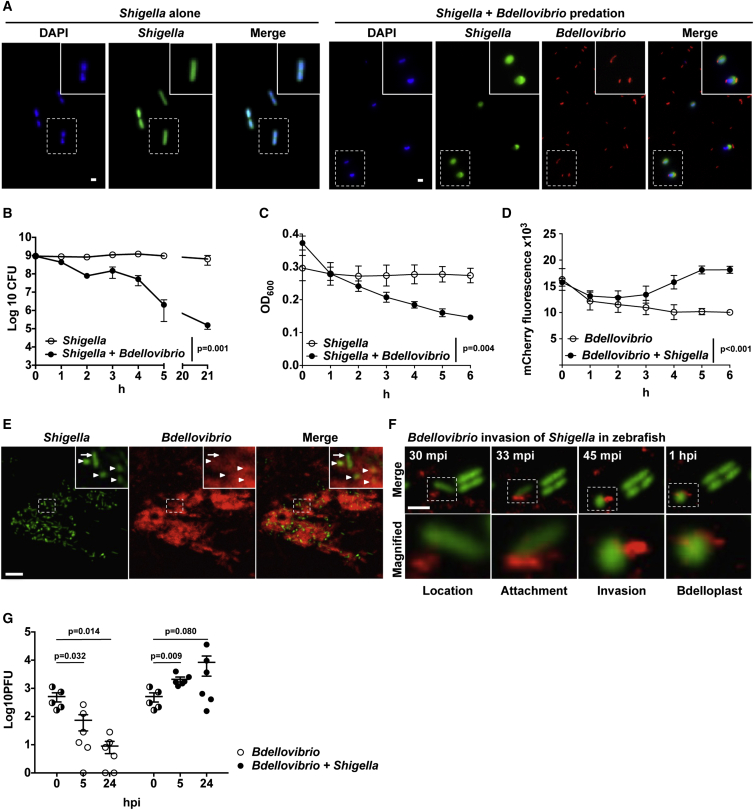
Bdellovibrio Prey on Shigella In Vitro and In Vivo inside Living Zebrafish(A) GFP-S. flexneri (green) were incubated in vitro, in the presence or absence of mCherry-Bdellovibrio (red), and visualized by wide-field fluorescent microscopy. Representative images, including rod-shaped Shigella and rounded Shigella invaded by smaller comma-shaped Bdellovibrio, were taken at 1 hr post-mixing. Scale bar, 1 μm.(B) 5–12 × 108 CFUs of GFP-S. flexneri were incubated, in vitro, in 10 mL CaHEPES buffer for 21 hr in the presence or absence of ∼6.2 × 1010 PFUs of mCherry-Bdellovibrio. Live Shigella were enumerated over time. Data are pooled from three independent experiments. Mean ± SEM (horizontal bars) is shown. The p value between conditions was determined by paired one-tailed Student’s t test. Significance was defined as p < 0.05.(C and D) 2–7 × 107 CFUs of GFP-S. flexneri, 8.4–10.4 × 109 PFUs of mCherry-Bdellovibrio, or both GFP-S. flexneri and mCherry-Bdellovibrio were incubated in vitro in CaHEPES buffer at 37°C. (C) Optical density 600 (OD600) representing Shigella numbers (Bdellovibrio are too small to contribute to OD600) or (D) mCherry fluorescence intensity representing Bdellovibrio numbers was measured every 30 min for 6 hr using a microplate reader (results plotted every 1 hr). Mean ± SEM from three biological replicates with three technical replicates each is shown. The p value between conditions was determined by paired one-tailed Student’s t test. Significance was defined as p < 0.05.(E) WT AB zebrafish larvae were injected at 3 dpf in the tail muscle with 103 CFUs of GFP-S. flexneri (green) followed by a tail muscle injection of 1–2 × 105 PFUs of mCherry-Bdellovibrio (red) 30–90 min after the initial Shigella infection. Larvae were imaged by confocal microscopy at 20× magnification. Representative images show the different morphologies of Shigella in vivo, including the typical rod-shaped Shigella (arrow) and also a high proportion of rounded Shigella (arrowheads) at regions of interaction with Bdellovibrio. Scale bar, 10 μm.(F) Representative images of predation of Shigella by Bdellovibrio in vivo, inside a larva injected as in (E) and imaged by high-resolution confocal microscopy at 63× magnification. Frames captured over time show stages of Bdellovibrio (red) invasive predation and rounding of Shigella (green) in vivo. Scale bar, 2.5 μm. mpi, minutes post-infection. See also Movie S2.(G) WT AB zebrafish larvae were injected in the hindbrain ventricle at 3 dpf with 2–6 × 105 CFUs of GFP-S. flexneri (green) alone or followed by a hindbrain injection of 1–30 × 102 PFUs of mCherry-Bdellovibrio (red) 30–90 min after the initial Shigella infection. Bdellovibrio were diluted 100-fold from usual injections to facilitate enumeration of any replicated predators. Enumeration of live Bdellovibrio in PBS-treated homogenates of larvae over time is shown. Each circle represents a count from an individual larva. Half-filled circles represent enumerations from larvae at time 0 and are representative of inocula for both conditions. Only viable larvae were included in the analysis. Data are pooled from two independent experiments (up to n = 3 larvae per time point per experiment). Mean ± SEM (horizontal bars) is shown. The p values (versus the 0 hpi time point) were determined by multiple t test. Significance with Bonferroni correction was defined as p < 0.0125. Of note, p values (not displayed on figure) between conditions at cognate time points were determined by unpaired one-tailed Student’s t test with significance defined as p < 0.05. These are as follows: p < 0.001 between conditions at 5 hr and p < 0.0852 at 24 hr.